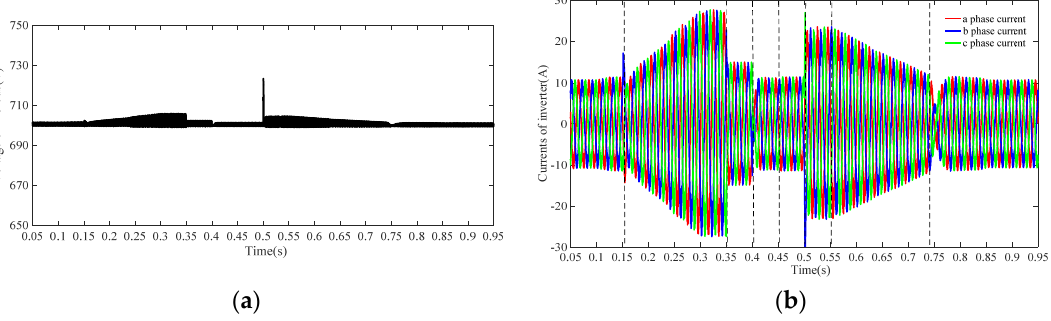
Figure 13. DC ‐ link voltage and inverter output current: ( a ) DC ‐ link voltage; ( b ) three ‐ phase output Figure 13. DC-link voltage and inverter output current: ( a ) DC-link voltage; ( b ) three-phase current. output